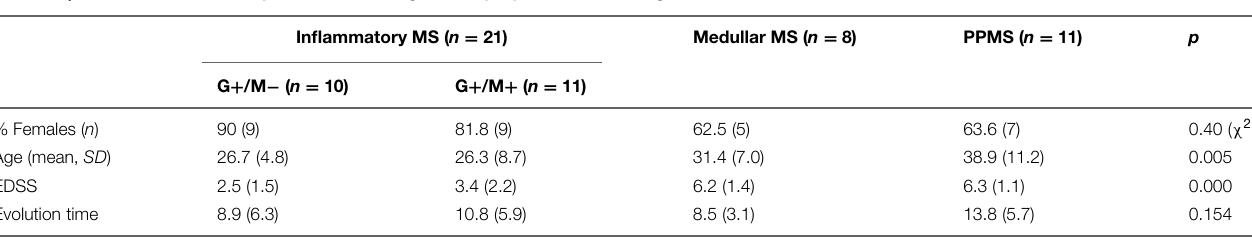
TABLE 5 | Characteristics of MS patients according to new proposal and working classification.